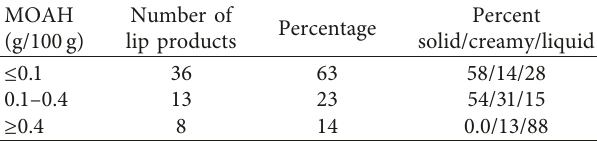
Table 10: Categorization of MOAH content among lip